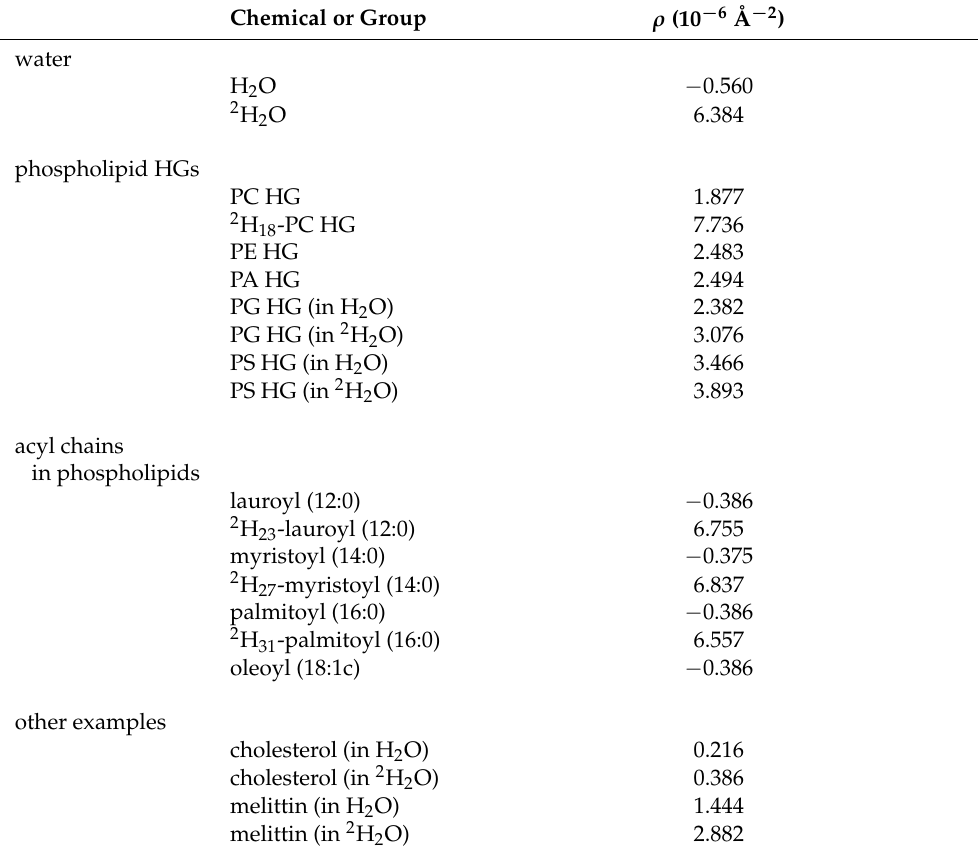
Table 2. Example neutron SLDs encountered in SANS studies of biomembranes. Chemical or